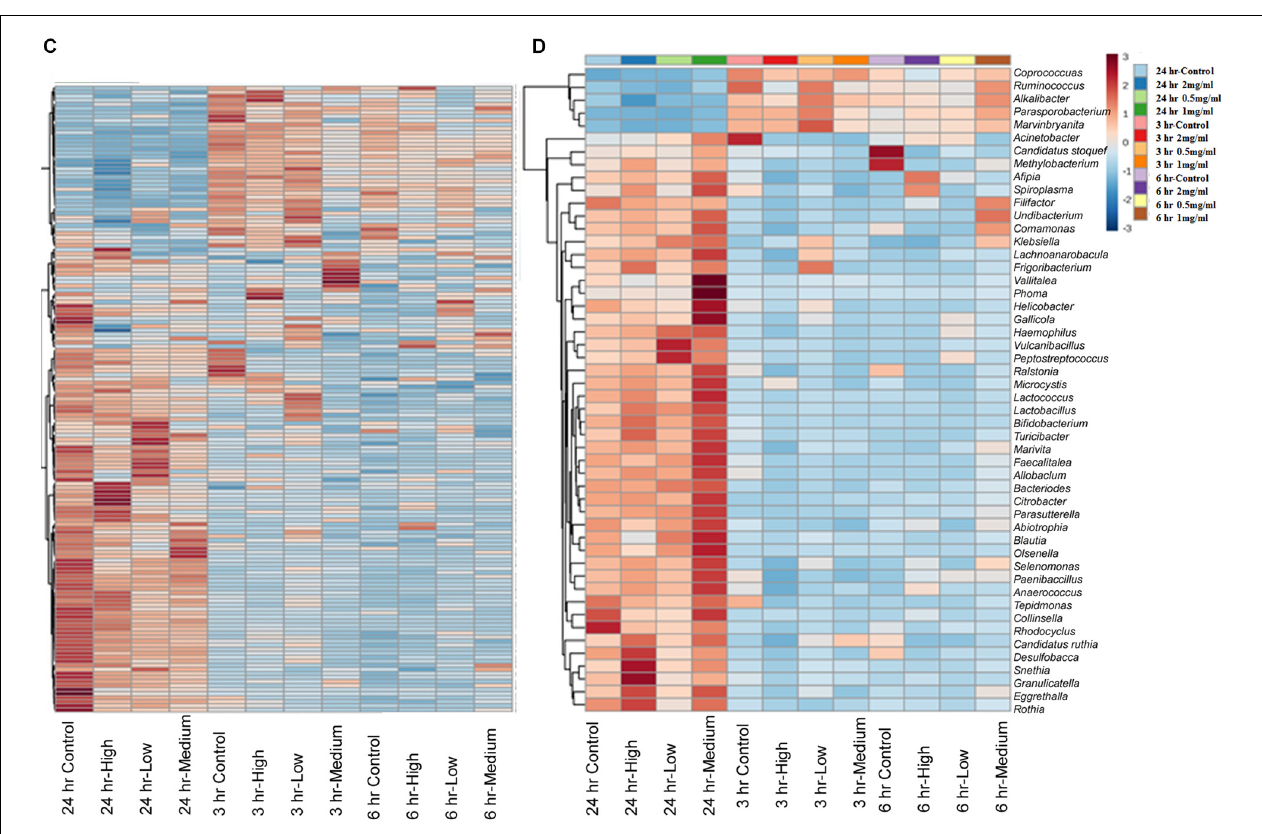
FIGURE 6 | The effect of aloin on intestinal bacterial community at genus level. (A) The PCA plot shows clear segregation of bacterial community at the genera level at 24 h time point samples not observed in the samples from other two-time points. Samples collected from both 3 and 6 h time points are grouped tightly together. This analysis call for the n = 4. Here the X -axis is the bacterial genera and the Y variables are observations of different treatment groups compared together. (B) These figures show that aloin exposure alters the bacterial community either by increased or decreased bacterial abundance at the genus level. Here we show representative examples for high and low abundance bacterial genera due to aloin treatment. (C,D) The displayed heat map provides an in-built visualization of the OTU abundance and displays the similarities and differences in data subsets. In the heat map, each colored cell represents abundance of bacterial community in each experimental groups/samples (beta-diversity). (C) The left panel of heat map shows the abundance of bacterial population at the genus level in control and aloin treated experimental groups. (D) The right panel (heat map) shows the top 50 bacterial genera that altered (either increased or decreased) due to aloin